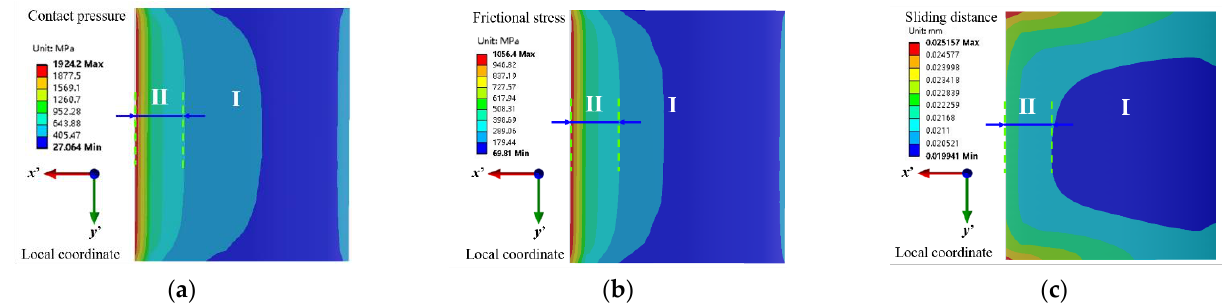
Figure 15. Contact state of the contact surface for the numerical results (13,500 N). ( a ) Contact pressure; ( b ) frictional stress; ( c ) sliding distance.